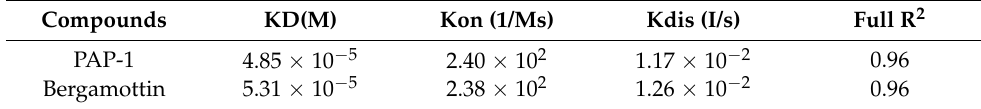
Table 2. The interaction between compounds and ACE2 proteins.